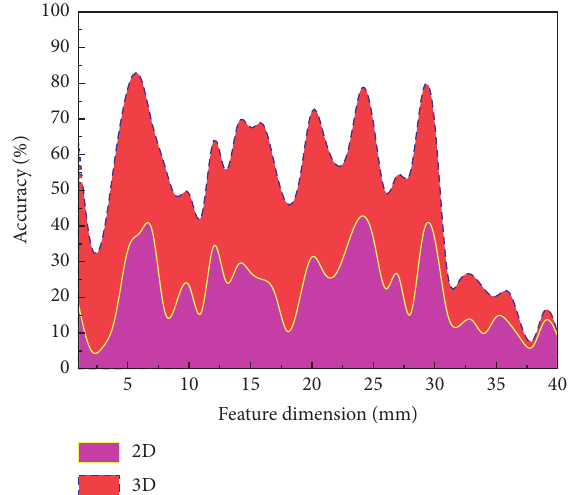
Figure 10: Visual hull model identification results for different error motion dataset feature